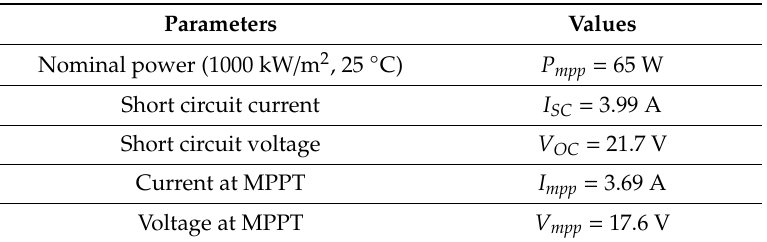
Table A1. Specification of the PV panel